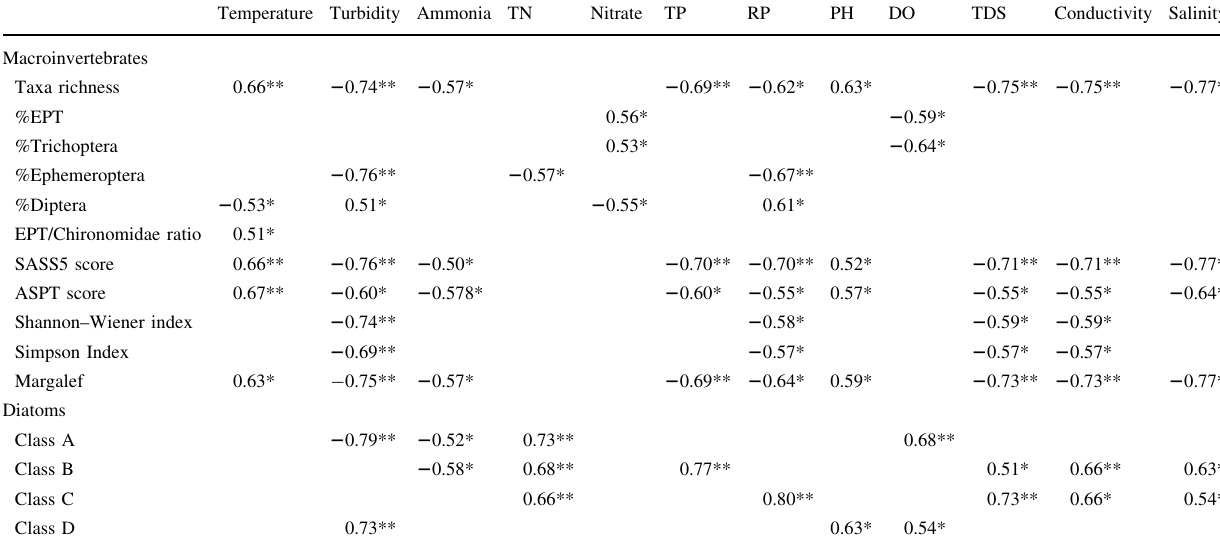
Table 3 Spearman correlation coefficient between physico-chemical variables vs community metrics and diversity indices along the Ngamo River